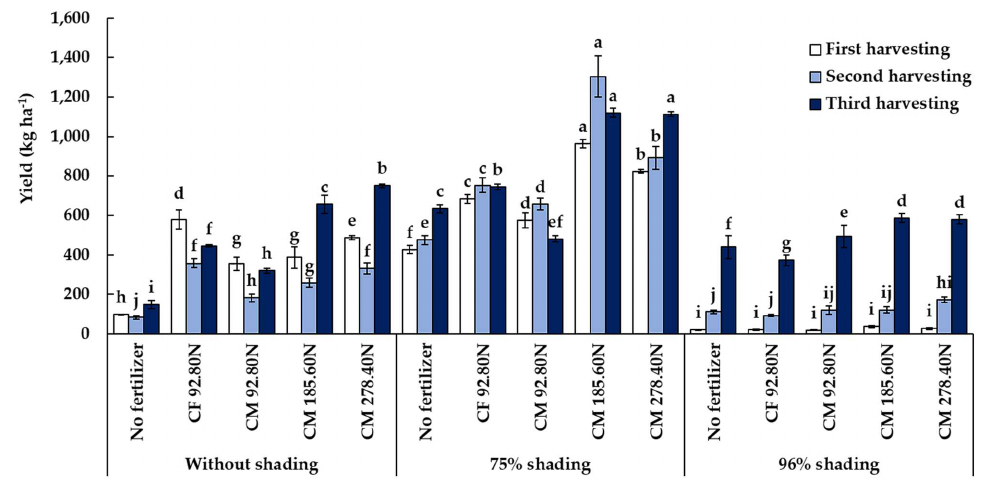
Figure 3. Vegetable fern yield under different shading and fertilizer application treatments at each harvesting time. Values are means with standard deviations ( n = 4). The different letters above the bars indicate statistically significant differences by Duncan’s multiple range tests ( p < 0.05) within each harvesting month.